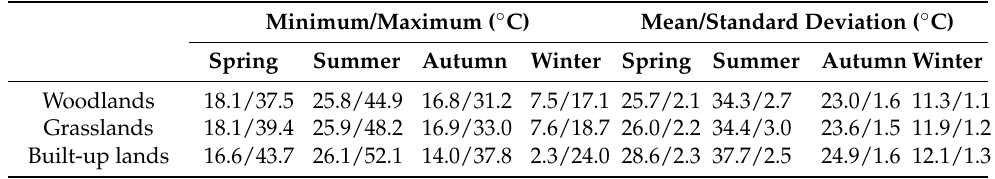
Table 5. Descriptive statistics of the density plots in Figure